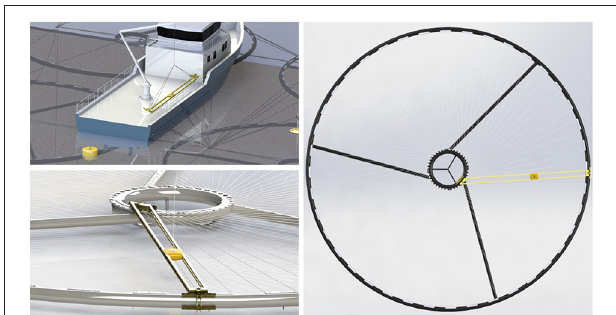
FIGURE 1 | An overview of some of the details of the Standardized Production of Kelp (SPOKe) concept. (Top left) Service vessel launches gantry robot on to submerged modules at the seaweed farm. (Bottom left) Gantry robot attached to module, applying string. (Right) SPOKe module with tool attached. Illustrations from the VR